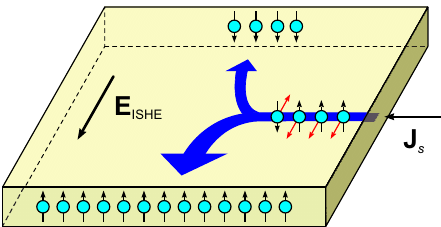
Figure 1. Inverse spin-Hall effect. A spin polarized current density J s undergoes asymmetric spin-orbit-induced scattering. The charges accumulated on the sides of the conductor generate an electromotive field E ISHE